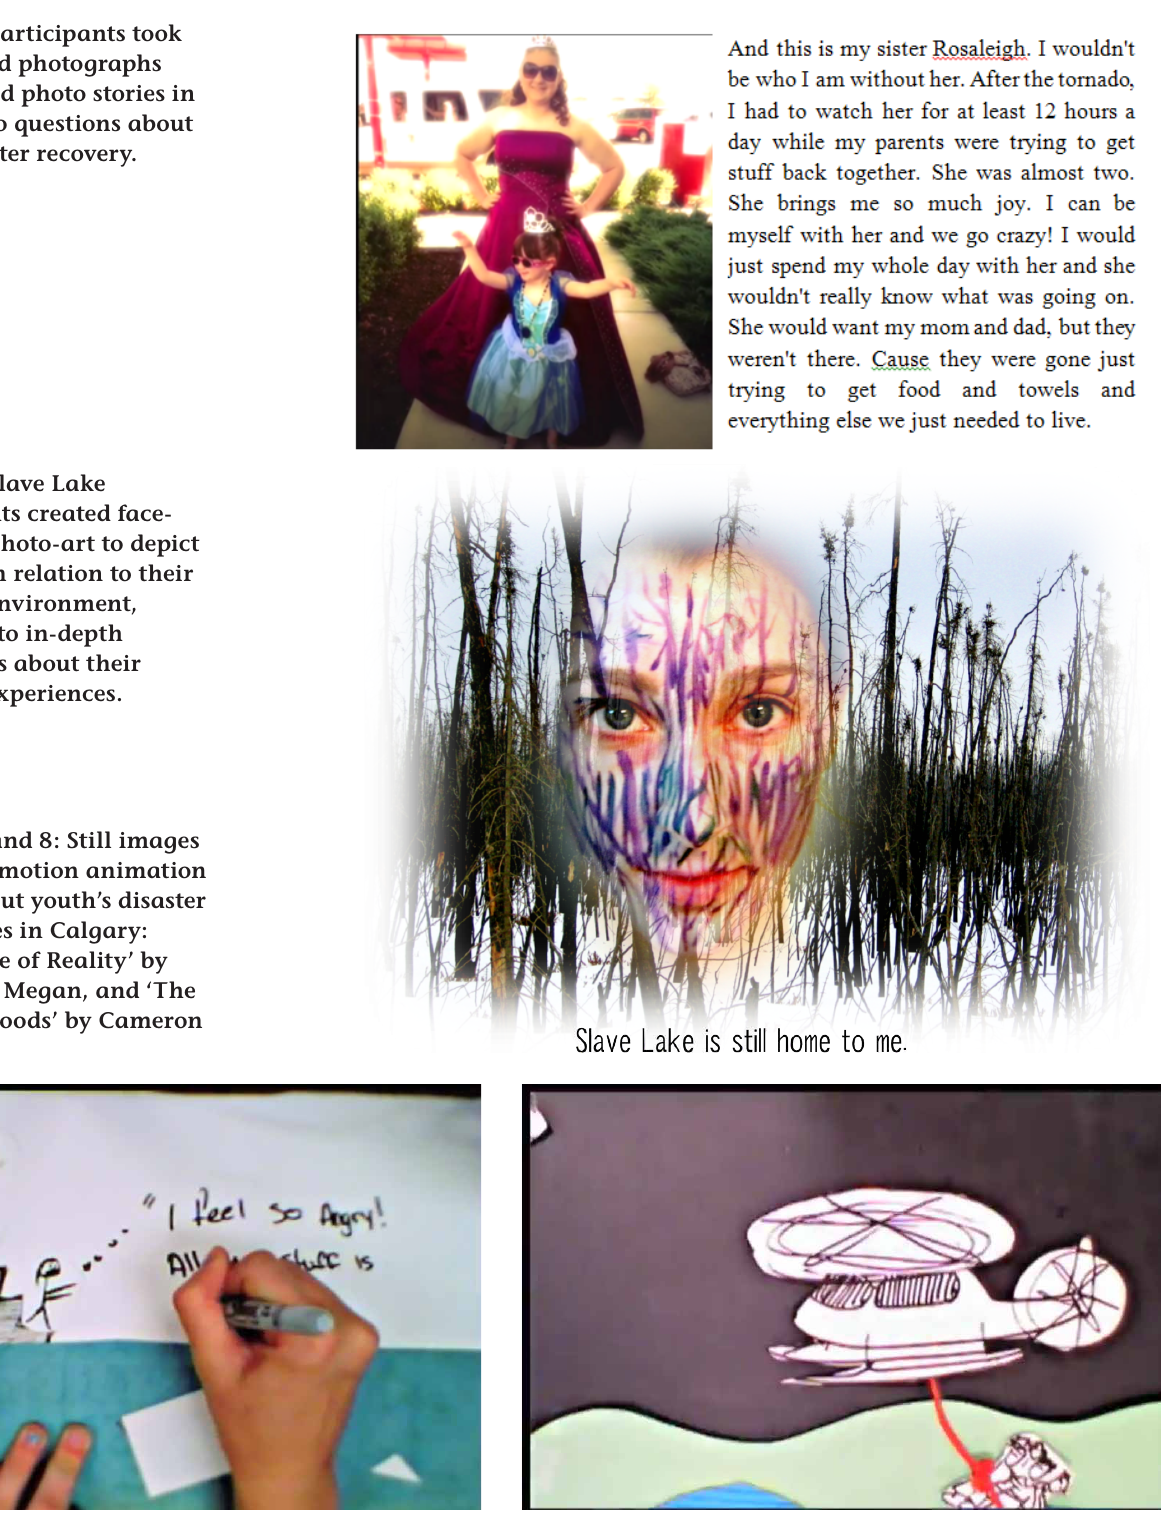
Figure 5: Participants took or retrieved photographs and created photo stories in response to questions about their disaster recovery.